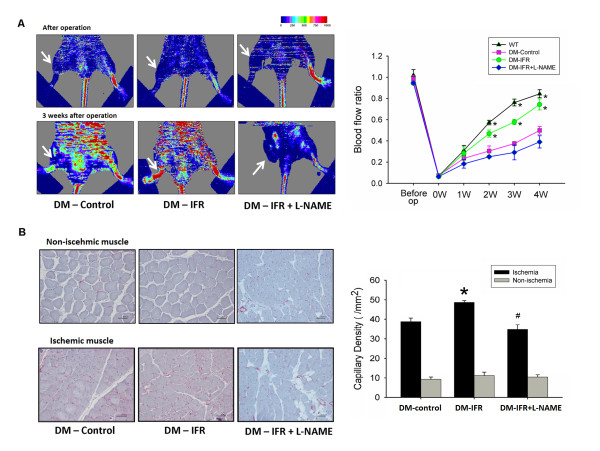
 Effects of far infrared (IFR) therapy on blood flow recovery and new vessels formation in STZ-induced diabetic mice. (A) Representative results of laser Doppler measurements before operation and 4 weeks after hindlimb ischemia surgery in wild-type mice, control (vehicle), IFR therapy, and IFR + NG-nitro-L-arginine methyl ester (L-NAME) mice. Color scale illustrates blood flow variations from minimal (dark blue) to maximal (red) values. Arrows indicate ischemic (right) limb after hindlimb ischemia surgery. Doppler perfusion ratio (ischemic/non-ischemic hind limb) over time in the different groups. Administration of L-NAME in drinking water abolished the beneficial effect of IFR therapy in diabetic mice. (*p < 0.05 compared with DM-control; #p < 0.05 compared with DM-FIR; n = 6) (B) Mice were sacrificed 3 weeks after surgery and capillaries in the ischemic muscles were visualized by anti-CD31 immunostaining. Results are mean ± standard error of mean (SEM). (*p < 0.05 compared with DM-control; #p < 0.05 compared with DM-IFR; n = 6).